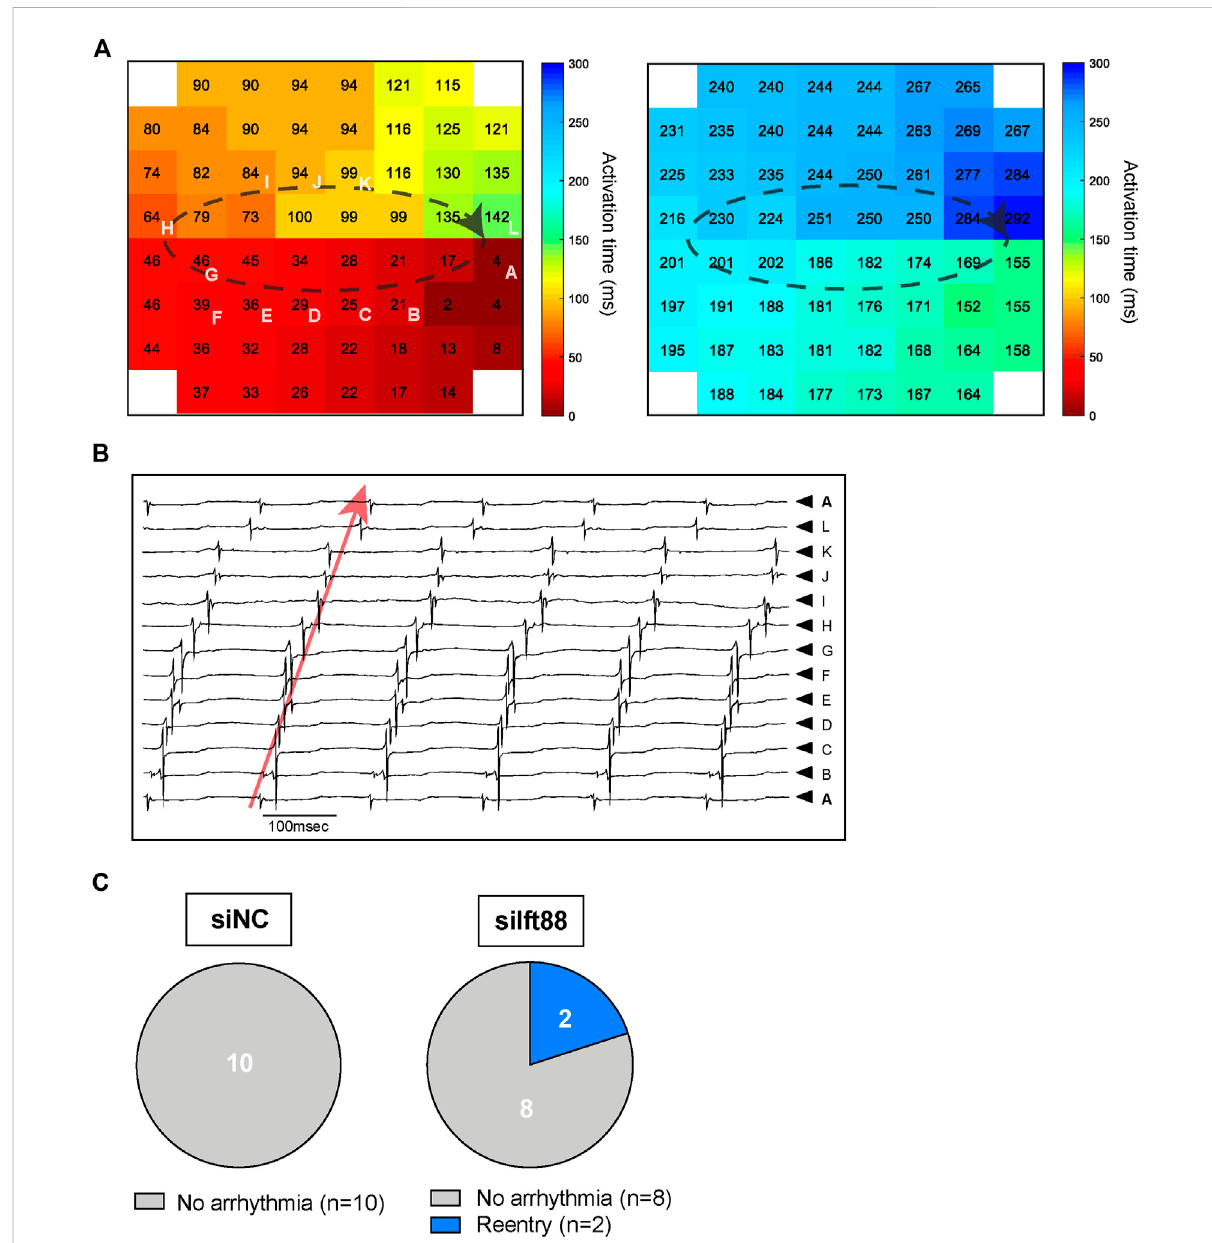
FIGURE 3 Reentry in CM co-cultured with siIft88 FB. (A) Activation maps of two following beats showing reentrant circuit and obtained from one CM monolayerco-culturedfor48 hwithFBpreviouslytransfectedwithsiIft88.Colorsindicateactivationtimes,accordingtothescaleatright.Dashedblack lineindicatedreentrantconductionpattern.Lettersindicateelectrodesfromwhichselectedunipolarelectrogramsaredepictedin (B) . (B) Electrograms selected along the reentry circuit. Red arrow shows that the diastolic interval is spanned within local activation (electrogram from electrode A is repeated on top and at the bottom) as expected during reentry. The letters next to the electrograms indicate electrodes from which selected unipolar electrograms are shown (A) . (C) Proportion of CM-FB co-cultures showing reentrant arrhythmia or no arrhythmia in the siNC and siIft88